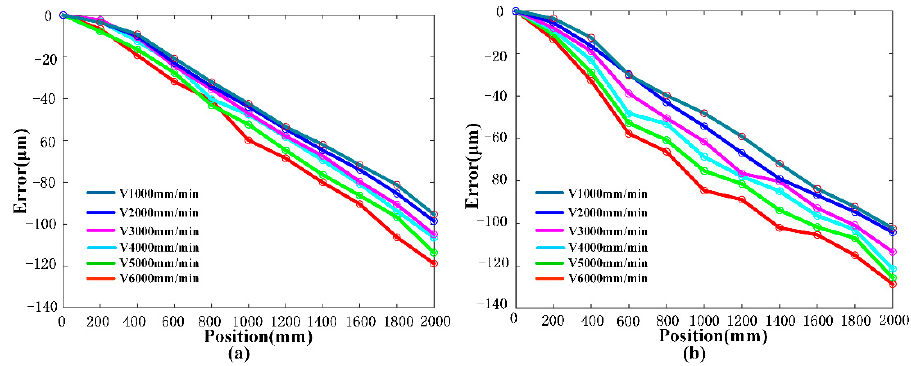
X Δ and X Δ . ( a ) x 1 -axis positioning error curve; ( b ) x 2 -axis 1 x 2 x